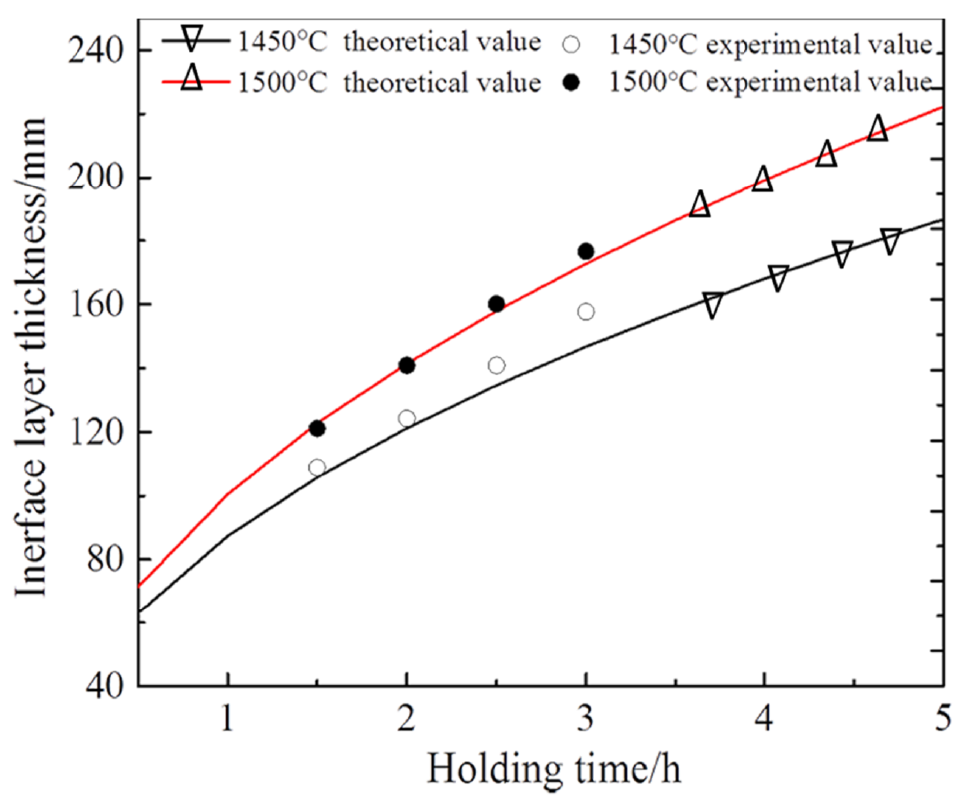
Figure 13. The relationship between the interface layer thickness and the holding time at different sintering temperatures.